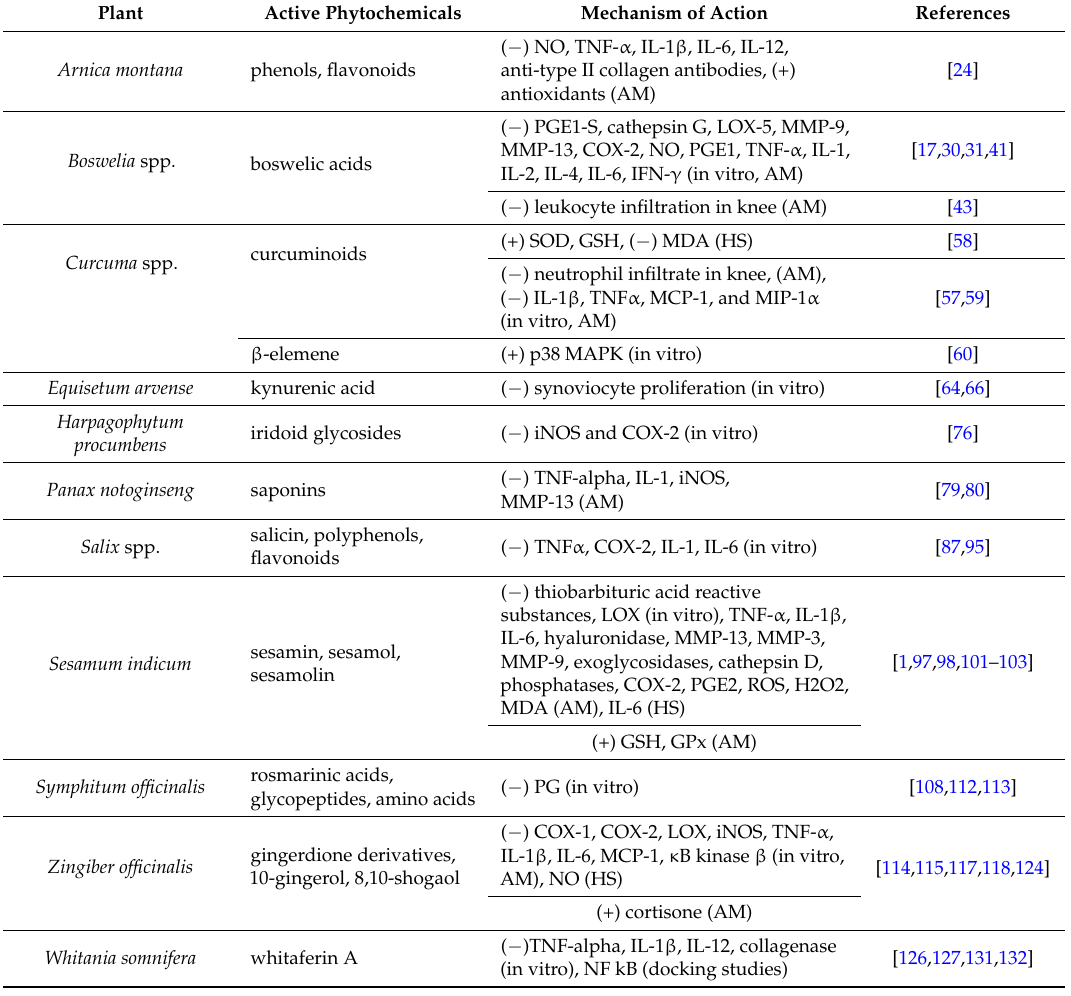
Table 1. Medicinal plants with therapeutic potential in ostheoarthritis and rheumatoid arthritis (Legend: AM, animal model; CAT, catalase; COX, cyclooxygenase; GPx, glutathione peroxidase; GSH, glutathione; GST, glutathione-S-transferase; HS, human study; IL, interleukine; iNOS, inducible nitric oxide synthase; LOX, lipooxygenase; PGE1-S, prostaglandin E2 synthase; ROS, reactive oxygen species; SOD, superoxide dismutase; MAPK, mitogen-activated protein kinase; MCP-1, monocyte chemoattractant protein-1; MIP-1 α , monocyte inflammatory protein-1; MMP, matrix metaloproteinase; NO, nitric oxide; TNF, tumoral necrosis factor; ( − ), decreased synthesis/decreased activation/inhibition of various mediators, enzymes, transcription factors, and processes; (+), increased synthesis/increased activation of various mediators, enzymes, transcription factors, and